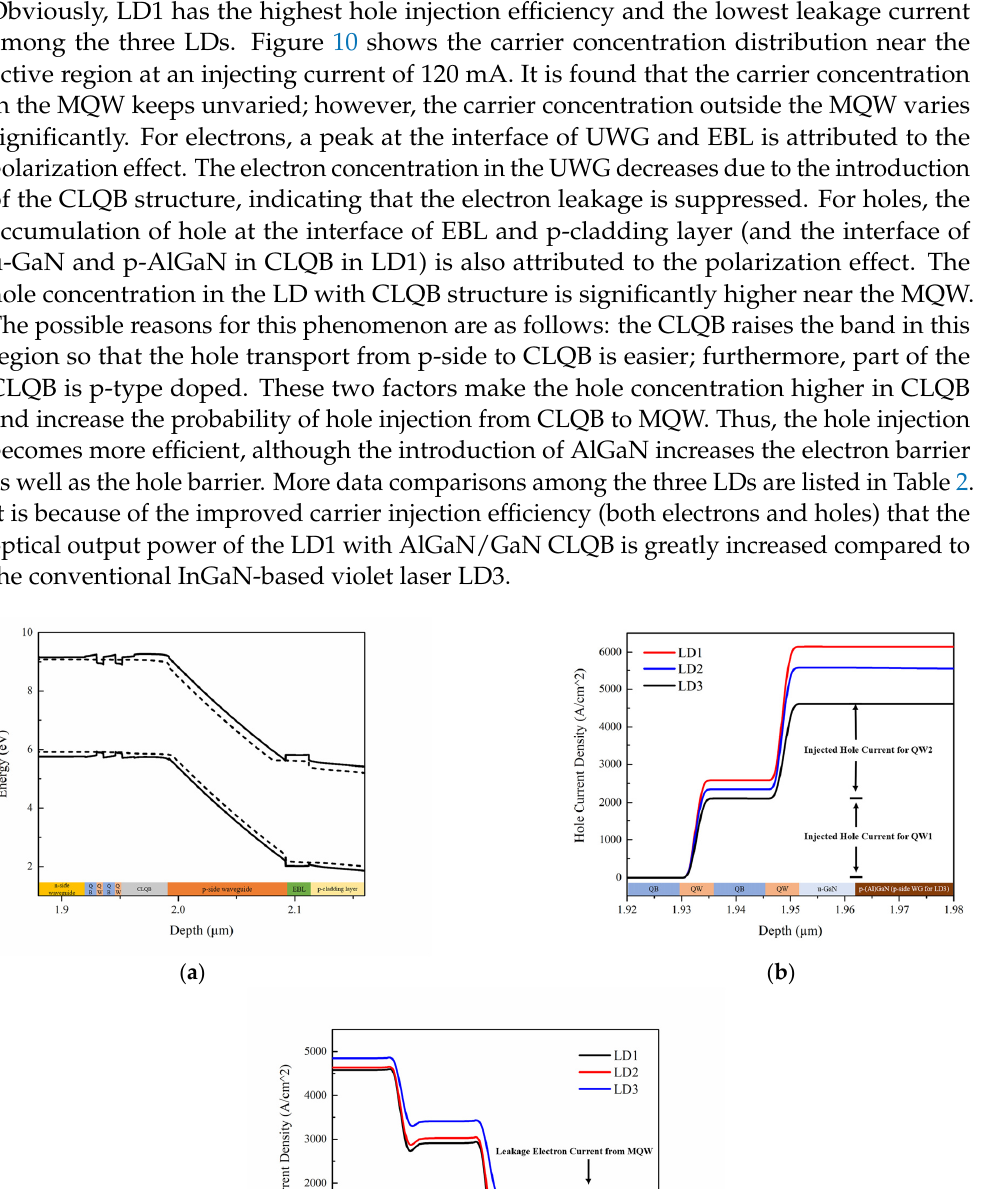
( b ) Figure 10. The simulated electron and hole concentration distribution around MQW of three LDs. ( a ) electron concentration distribution at an injecting current of 120 mA; ( b ) hole concentration dis- tribution at an injecting current of 120 mA.